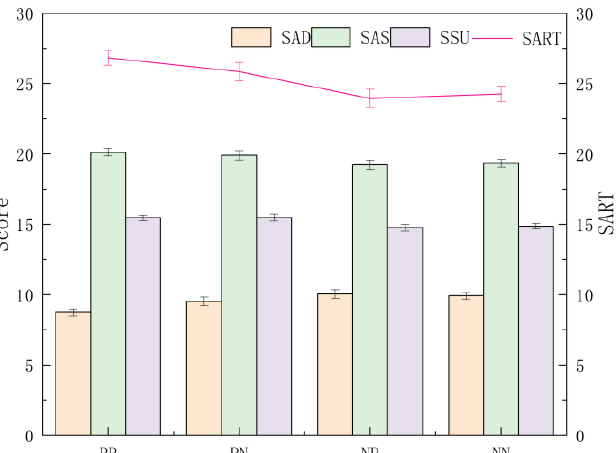
Figure 8. The dimension and total scores obtained by SART for each presentation frame. Note. Score: the dimension score of SA; SART: total score of SA; AD: attention-demand dimension; AS: attention-supply dimension; SU: situation-understanding dimension; PP: positive–positive frame; PN: positive–negative frame; NP: negative–positive frame; NN: negative–negative frame; Error bar: standard error.